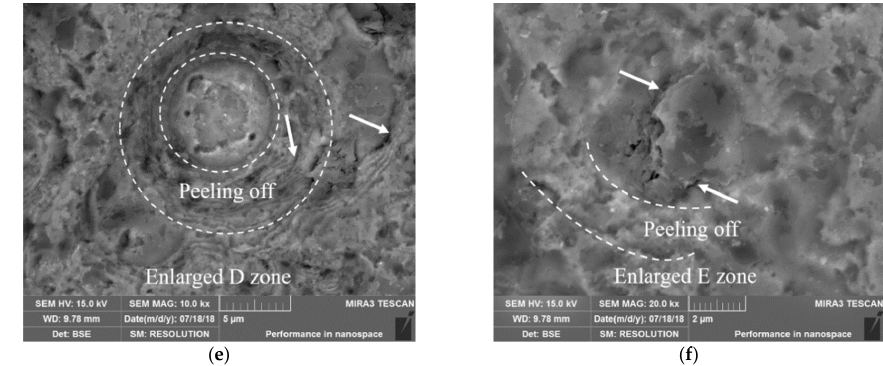
Figure 6. SEM micrographs of uncoated and coated samples after 60 g erosion testing: ( a,b ) are the uncoated sample, ( c ) is the erosion area, ( d ) is an enlargement of the white frame in ( c ), and ( e,f ) are an enlargement of the failed area with droplets defects (D) and stress concentration defects (E) during the coating process.